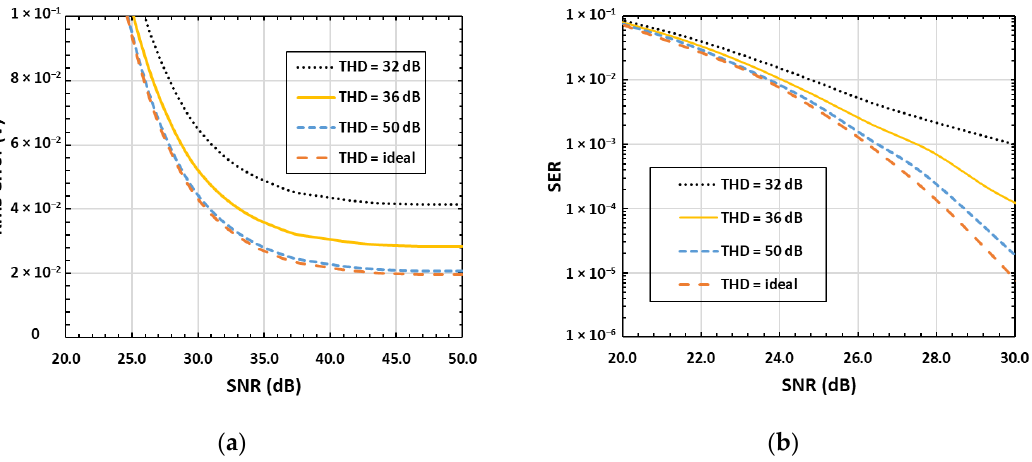
Figure 1. ( a ) RMS error (in volts from the ideal reconstruction of the digital values with a swing of 2 V pp ) and ( b ) SER as a function of SNR for different levels of AFE static THD, derived using a MATLAB simulation of a PAM-8 receiver.